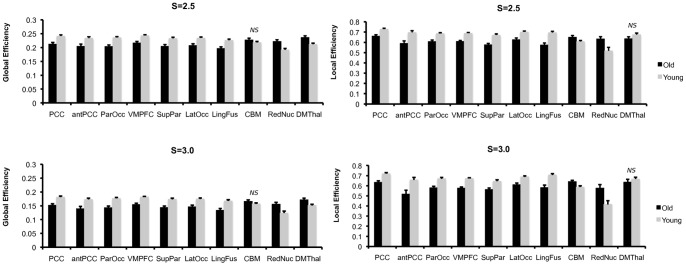
Age group differences in global and local efficiency.Group comparisons for all regions of interest were statistically significant based on post-hoc univariate ANOVAs at p<.05, except for those marked NS, see Tables 2 and 3. Note ROIs were generated based on an overlap of network integration measures (degree, global efficiency, and k-core); we illustrate group differences in local efficiency for comparison.